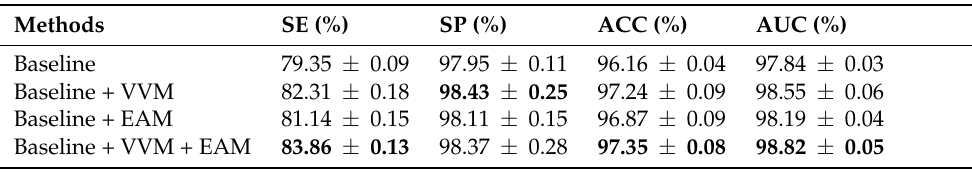
Table 3. Comparison of ablation studies on DRIVE dataset. VVM stands for VQ-VAE module, EAM denotes the eage attention module.